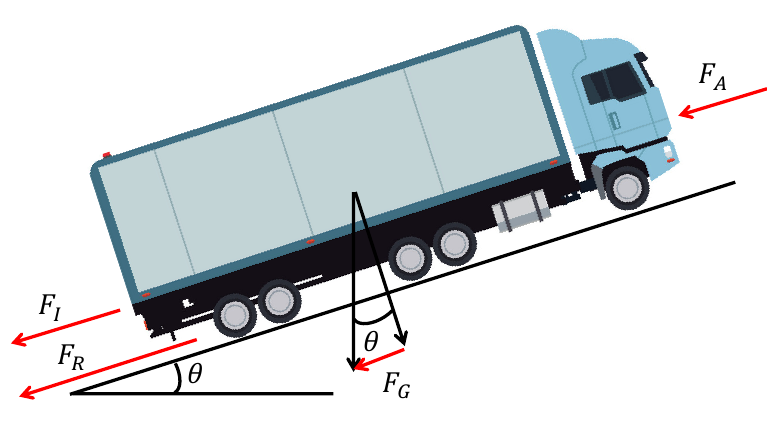
Figure 2. Forces acting on a